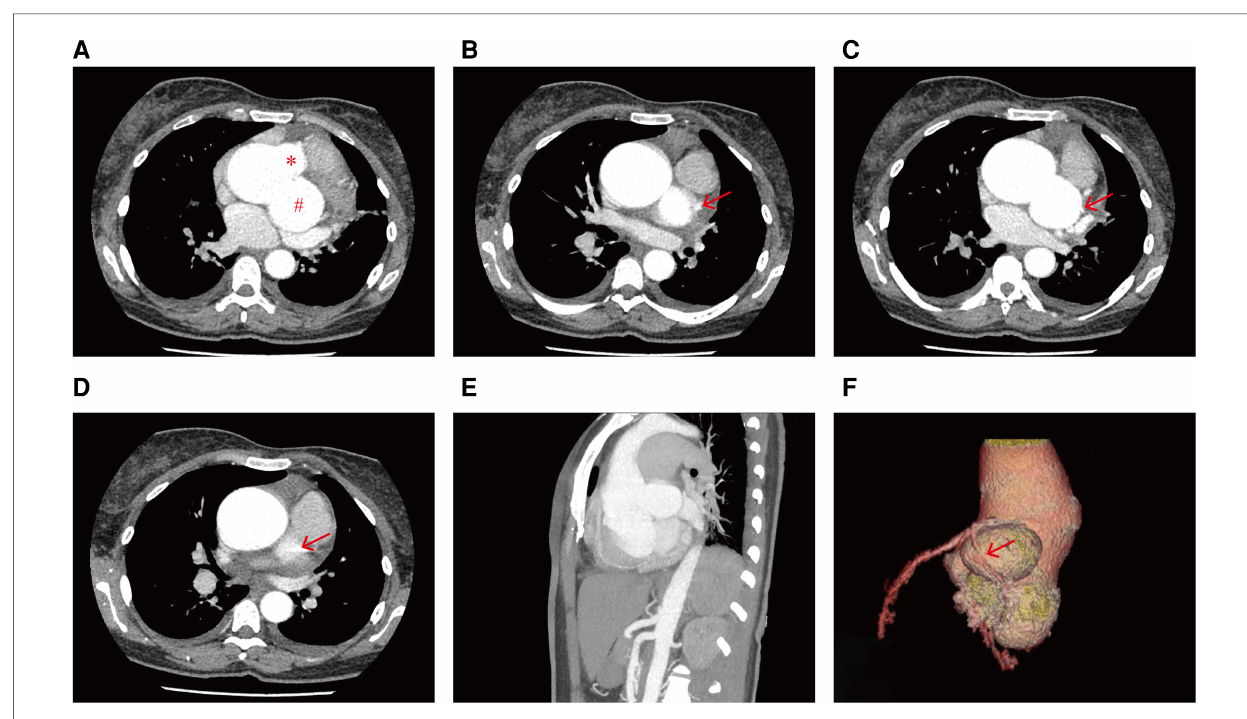
FIGURE 3 CCTA images showing ( A ) the unruptured left SVA (#) and non-coronary SVA (*), the effect of the dilated left SVA on the ( B ) LM (red arrow) and the ( C ) LCX (red arrow), and ( D ) the dilated left SVA upwardly squeezed the pulmonary trunk (red arrow). ( E ) Sagittal plane view of the dual unruptured left/ non-coronary SVAs. ( F ) Three-dimensional reconstruction image showing the dual unruptured left/non-coronary SVAs, passage of the LM and LCX, and compression of the LCX (red arrow).